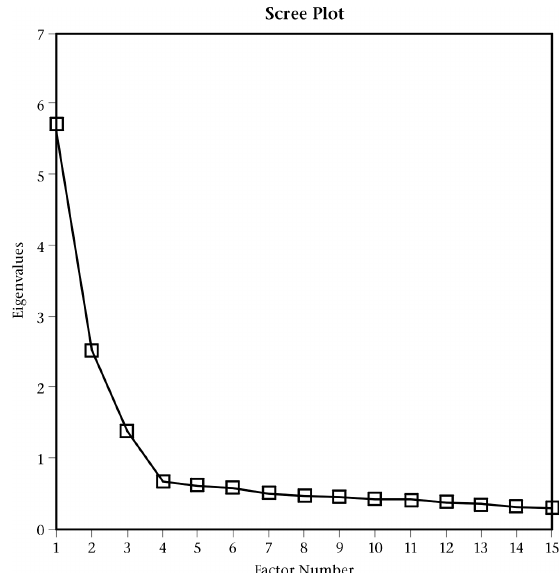
Figure 1. Scree plot of eigenvalues for the item parcel